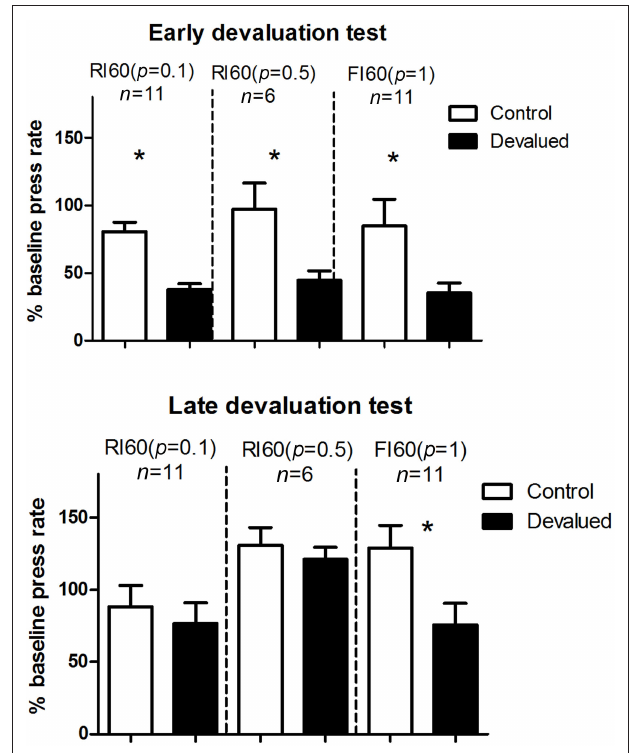
FIgure 3 | results from the two specific satiety outcome devaluation tests. Early devaluation, first outcome devaluation test was done after 2 days of training on the 60-s interval schedules. Late devaluation: second devaluation test was done after four additional days of training on the same 60-s schedules. For both, all mice were given a 5-min probe test conducted in extinction after specific satiety treatment.